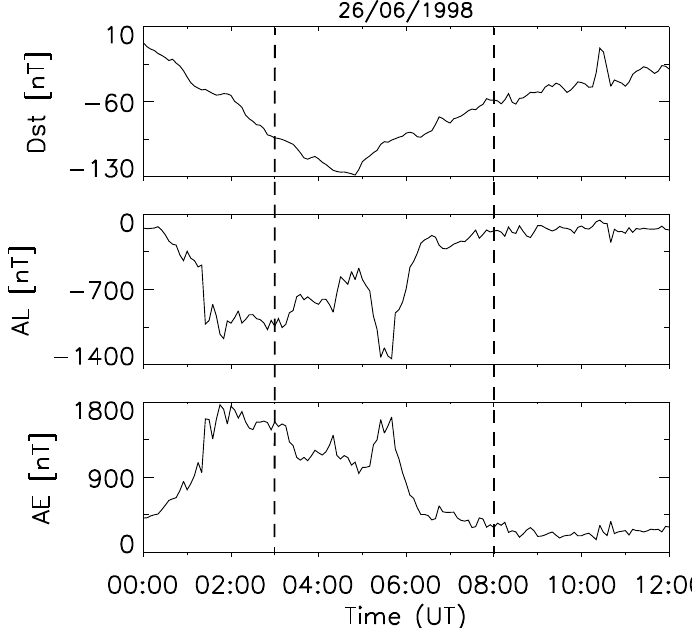
Fig. 1. The AE , AL and D st -indices between 00:00 and 12:00 UT on 26 June 1998. AE and AL are calculated from 63 stations between 55 and 76 ◦ in magnetic latitudes. D st is calculated from 24 stations below 40 ◦ in magnetic latitudes. The two vertical dashed lines indicate our time interval with data be- tween 03:00 and 08:00